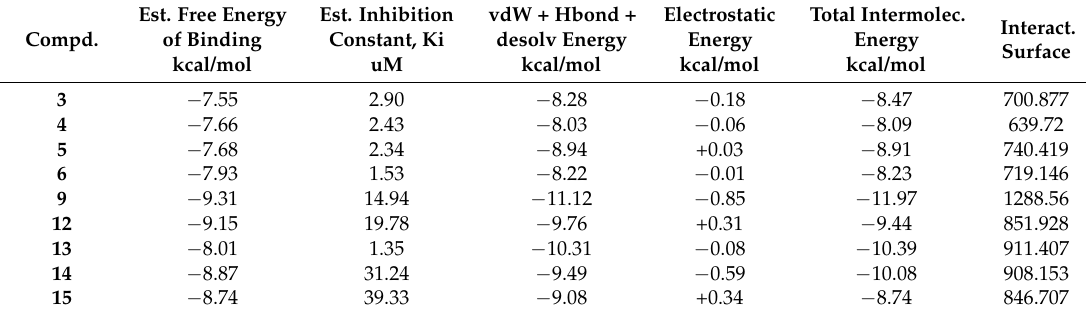
Table 3. Energy values obtained in docking calculations of some synthesized compounds with receptor breast cancer (3hb5).